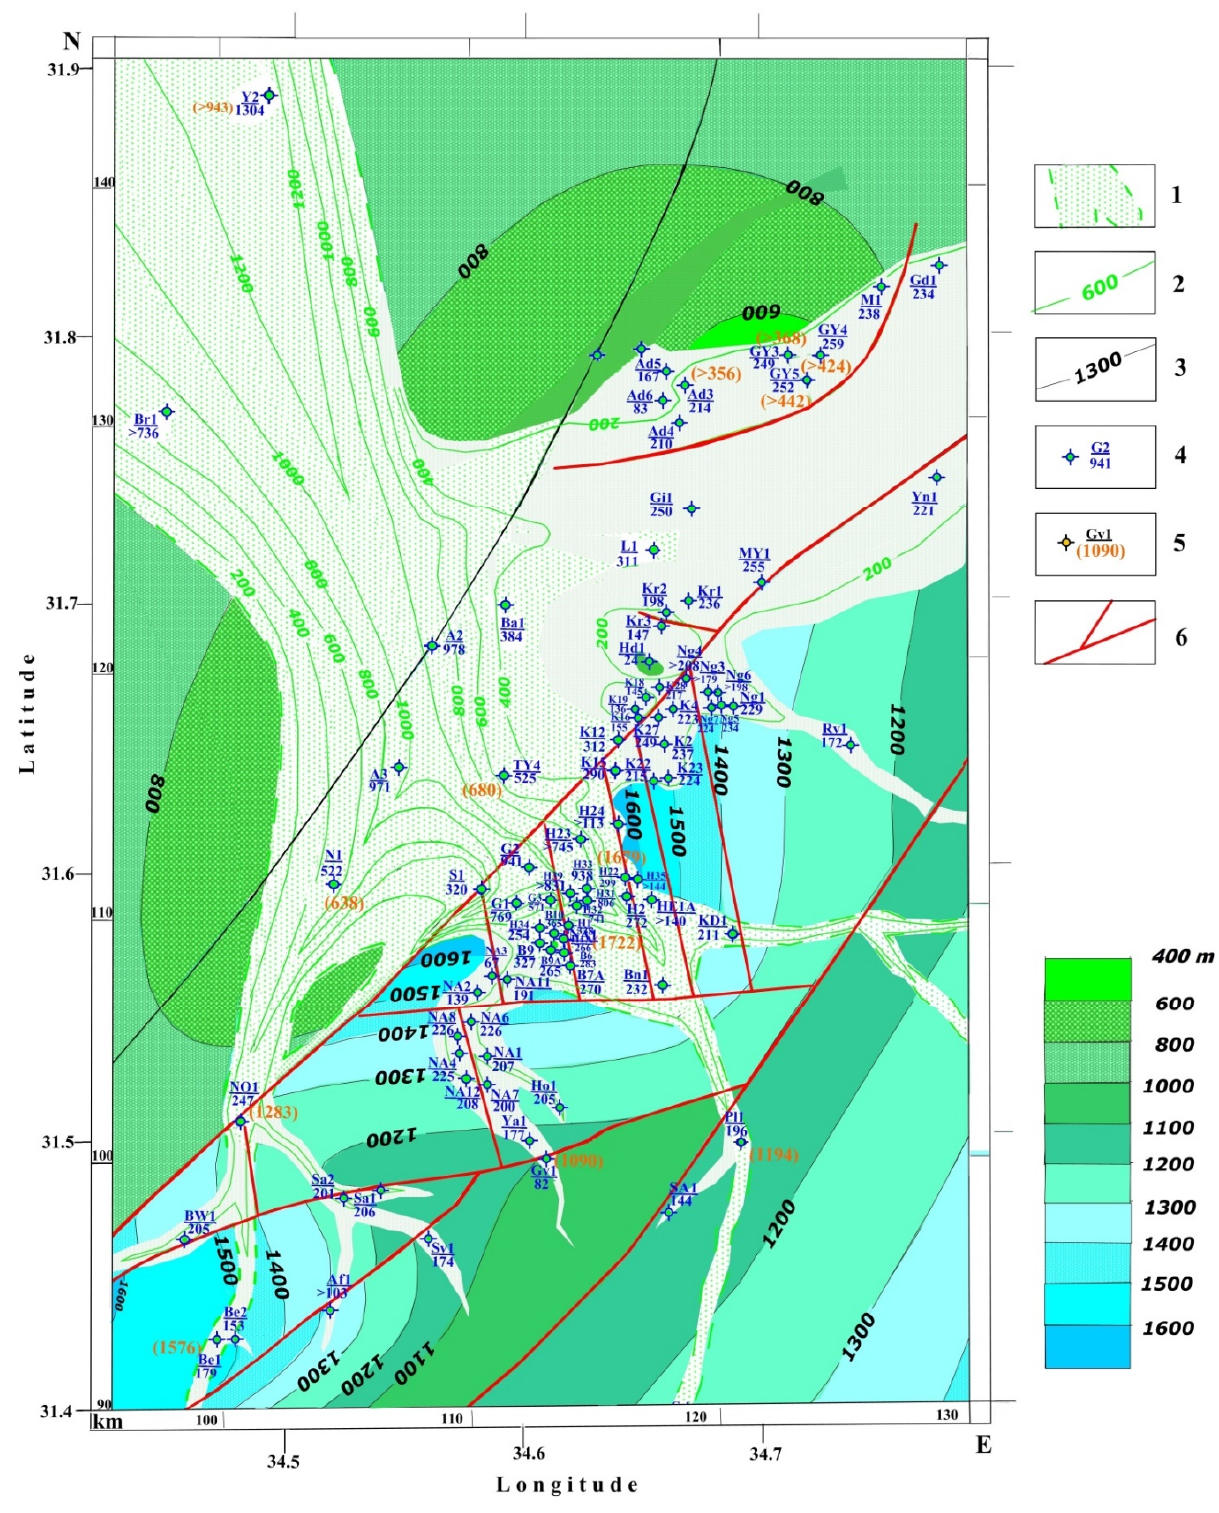
Figure 7. Paleogeomorphological map of the GevarAm erosional stage (Hauterivian–Barremian) of the Heletz–Ashdod oil field and adjacent areas. (1) The Early Cretaceous Gevar Am erosional zone, (2) isopachs of the Gevar Am Formation, (3) isopachs of the Upper—Middle Jurassic (Halutza—Upper Inmar formations) (in m), (4) boreholes penetrating Gevar Am Formation (nominator—borehole name and number, denominator—thickness in m, (5) boreholes penetrating Jurassic deposits (nominator—borehole name and number, denominator—thickness in m, (6) faults. Borehole abbreviations: see captions for Figure 2.